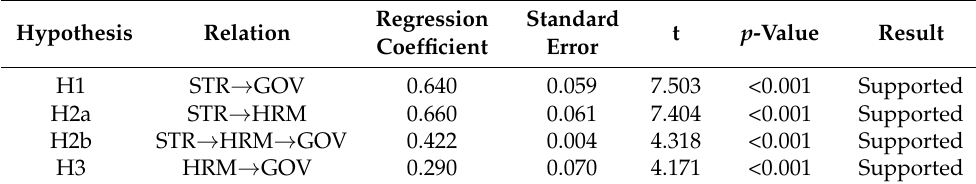
Table 2. Research hypotheses and statistical